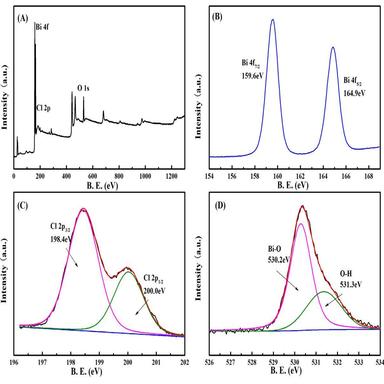
XPS spectra of Bi12O17Cl2-550: survey spectra (A), Bi 4f (B), Cl 2p (C), and O 1s (D).